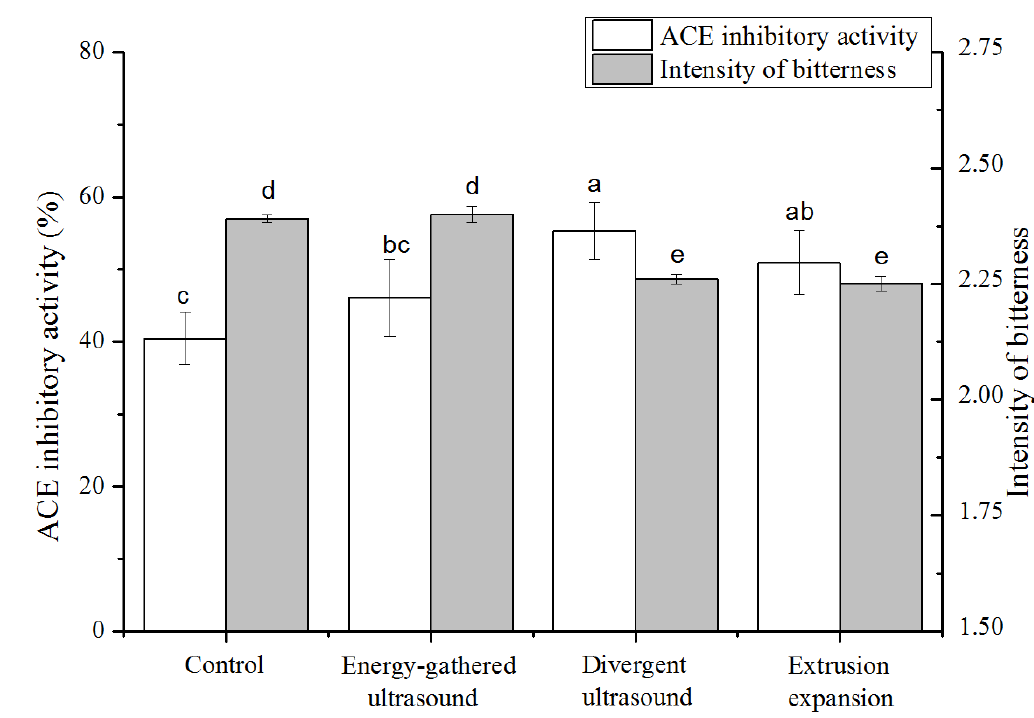
Figure 4. Effect of ultrasound pretreatment on the ACE inhibitory activity and bitterness intensity of CGMHs under optimal multi-enzymatic hydrolysis parameters. Significant differences between results are indicated by different letters ( p < 0.05).